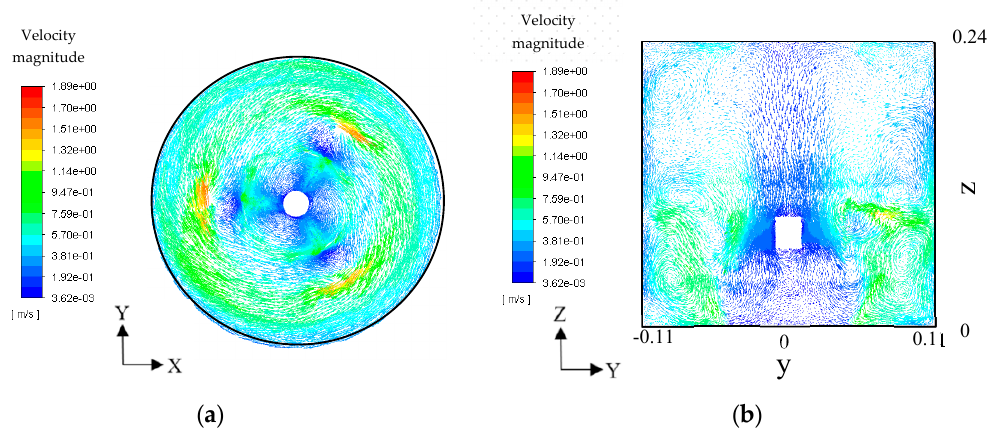
Figure 7. The velocity vectors in x – y ( a ) and y – z ( b ) cross-section plane for rotational speed at Re = 28,692.